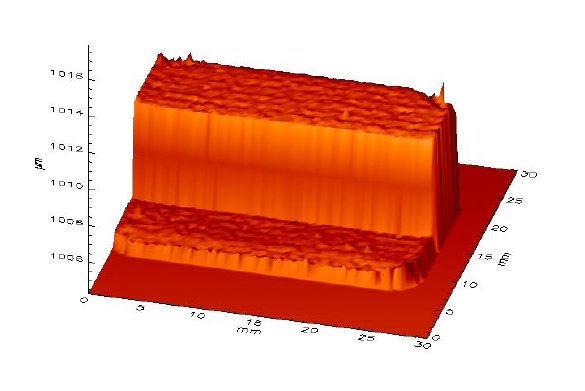
Fig. 3. 3D-plot of a 5 µm step. In Fig. 4a and c the same measurement data as in Fig. 3 are presented in a 2-dimensional plot with the thickness now being colour-coded. The thickness values along the green line in 4a and the red line in 4c are plotted in the profile graphs in the pictures 4b and 4d on the right. The profile graph in 4b along the green line runs parallel to the plane of the 1.01 mm standard measure demonstrating the vertical accuracy of the system. The profile graph in 4d runs across the step thus showing the accuracy of mapping the sharp step.